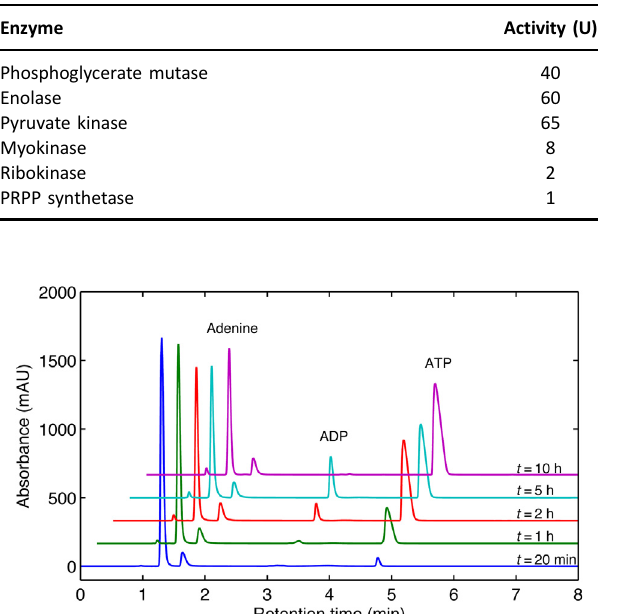
Table 11. Reagents for CTP